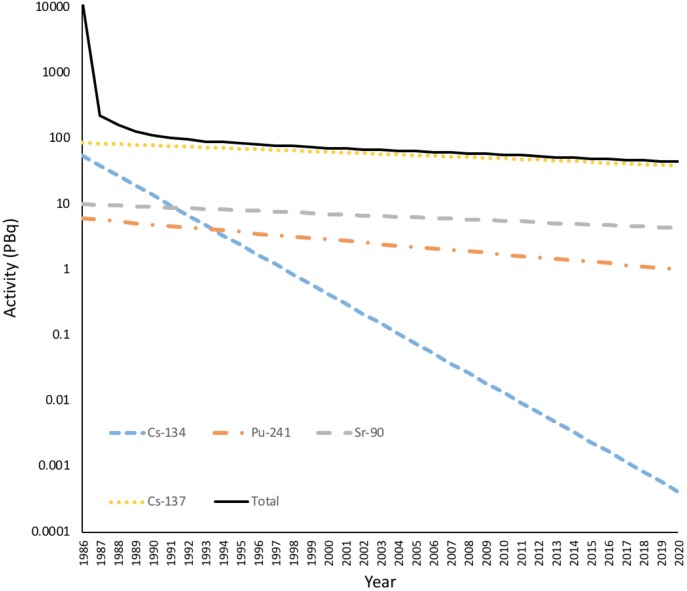
The Activity of radionuclides in the environment from the accident at Chernobyl. The total activity of radionuclides released from Chernobyl over a few days in 1986 was in excess of 11 EBq. Much of this was short-lived radionuclides such as 33Xe (6.5 EBq, λ = 5.3 days), 132Te (1.15 EBq, λ = 3.25 days), 131I (1.76 EBq, λ = 8 days), 99Mo (0.2 EBq, λ= 2.79 days), 141Ce (0.2 EBq, λ= 33 days). After a few years the remaining radioactivity was dominated by 137Cs, 134Cs plus some 90Sr and 241Pu. Radioactivity is now dominated by 137Cs. Many of the short-lived radionuclides are gaseous and emitted to the atmosphere but there was still a dramatic decrease in the dose to terrestrial organisms in the first year after the accident. (Full calculations given in Supplementary Data Sheet S3).